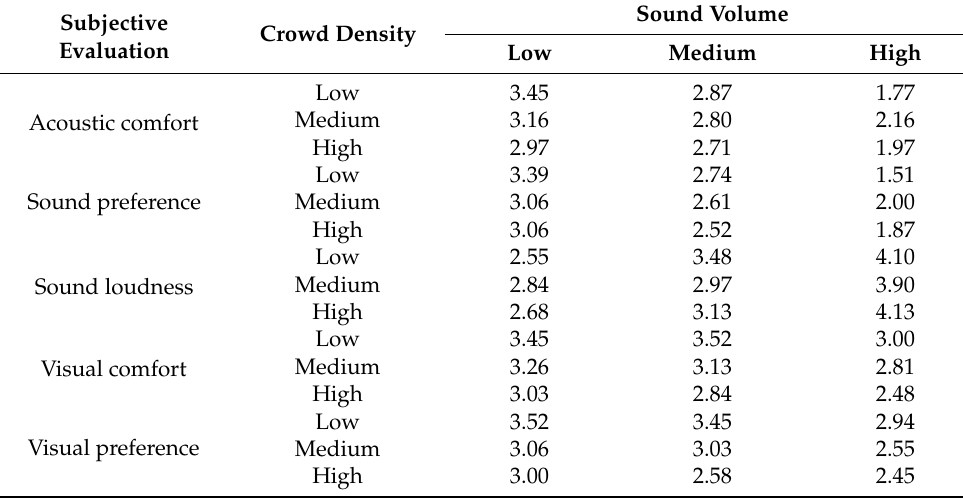
Table 3. The evaluation under the effect of sound and visual